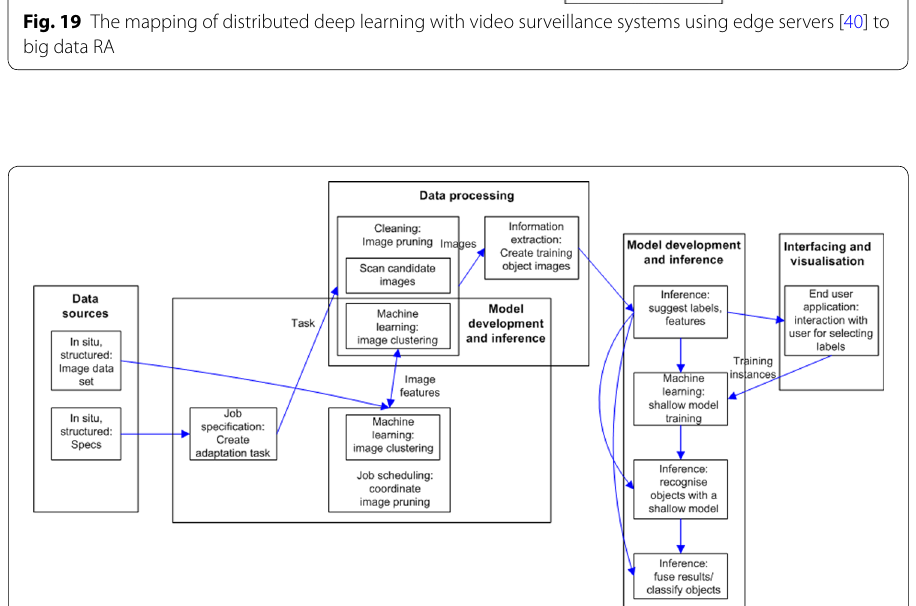
Fig. 20 The mapping of DeepCham [41] to the big data